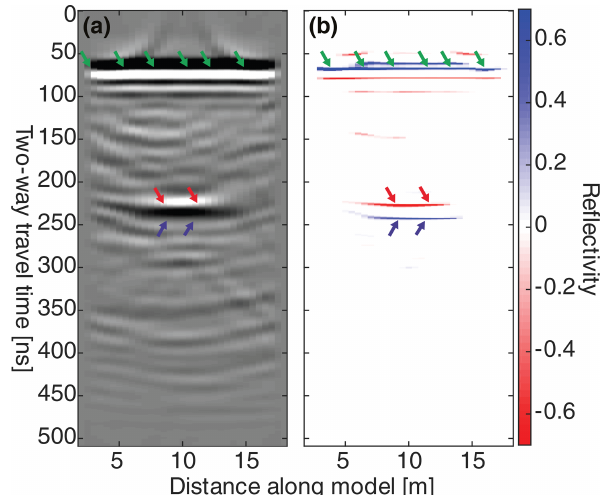
Figure 8. Forward modelling results for 0.3m water-filled conduit. (a) The processed synthetic data after step 10 in Table 2. (b) The re- flectivity from the data (a) after processing through the entire work- flow described in Table 2. The green arrows represent the direct arrival, and the red and blue arrows represent the interfering top and bottom reflection from the englacial conduit